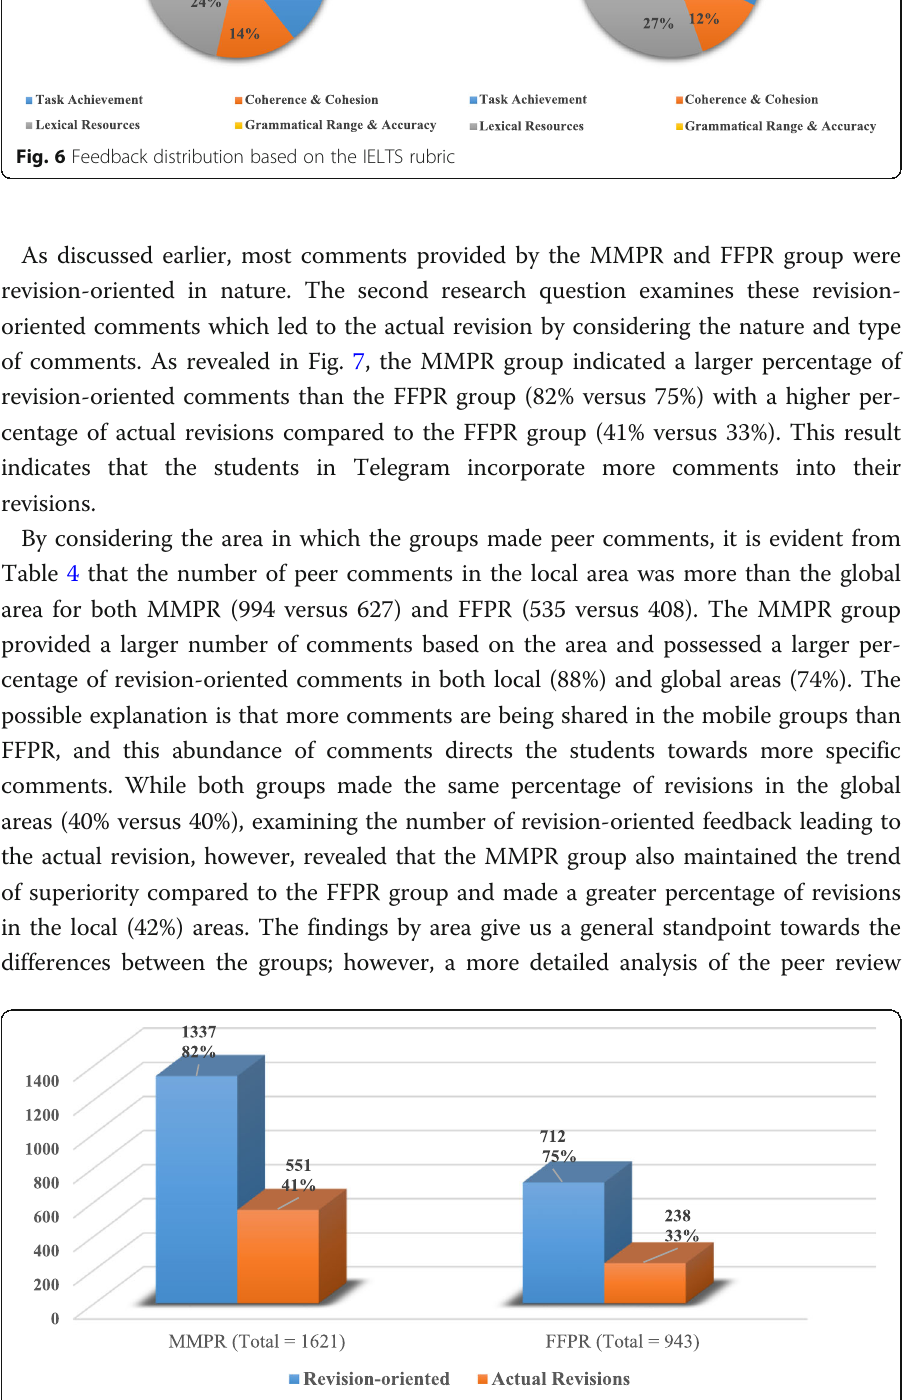
Fig. 7 Comparing the total feedback, revision-oriented feedback, and actual